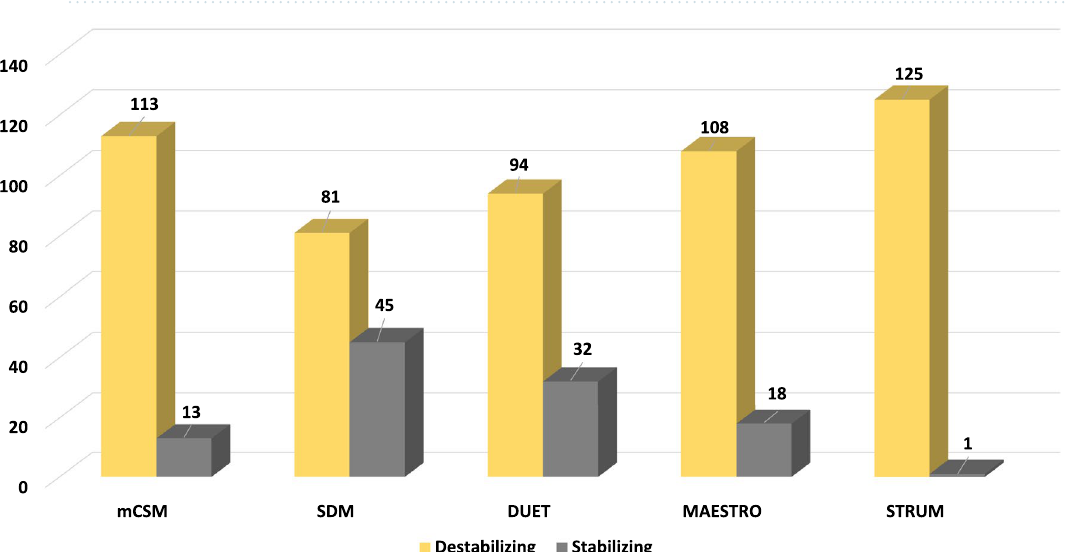
Figure 6. Distribution of destabilizing nsSNPs predicted by structure-based tools for the C-terminal OB-fold region of CTC1 protein. The vertical axis shows the number of mutations. The horizontal axis shows the structure-based tools; the yellow bar depicts the number of predicted destabilizing mutations and the grey bar depicts the number of predicted stabilizing